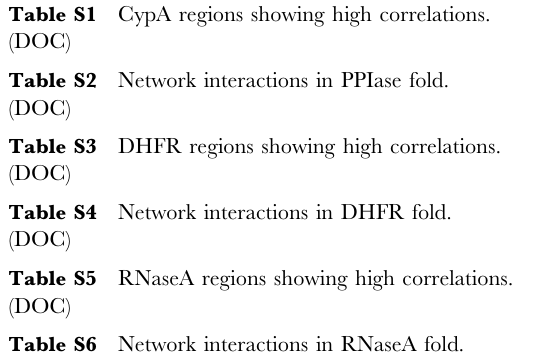
Table S1 CypA regions showing high correlations. Table S2 Network interactions in PPIase fold. Table S3 DHFR regions showing high correlations. Table S4 Network interactions in DHFR fold. Table S5 RNaseA regions showing high correlations. Table S6 Network interactions in RNaseA